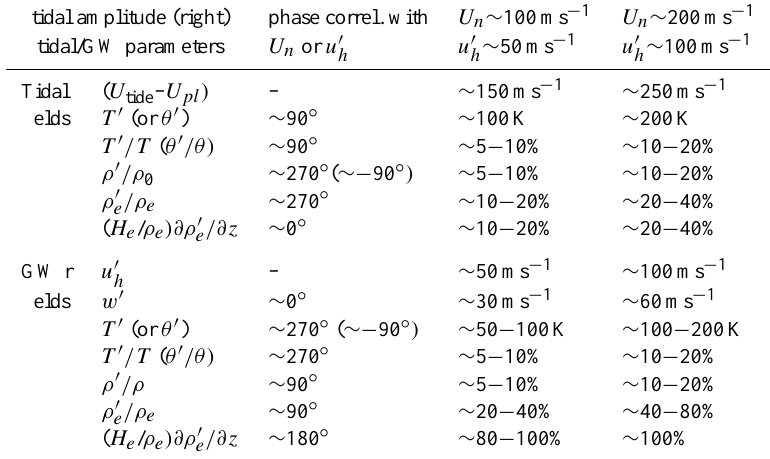
Table 5. Tidal and GW perturbations from the TIME GCM and GW theory, respectively, at the bottomside F layer with our assumptions of tidal and GW vertical wavelengths ( ∼ 300 and 150km, respectively), GW intrinsic frequency ( ω I ∼ N /2), and tidal and GW amplitudes (at top). Phase correlations show lags relative to the eastward tidal wind and GW horizontal wind in the direction of propagation (westward), U tide and u 0 , respectively. Estimates for ( U tide – U pl ) are at lower altitudes where the neutrals and plasma are not strongly coupled. Tidal h effects on electron densities are nominal, as they are difficult to distinguish from LT effects in the TIME GCM results. tidal amplitude (right) phase correl. with U n ∼ 100ms − 1 U n ∼ 200ms − 1 tidal/GW parameters U n or u 0 h Tidal ( U tide – U pl ) – ∼ 150ms −